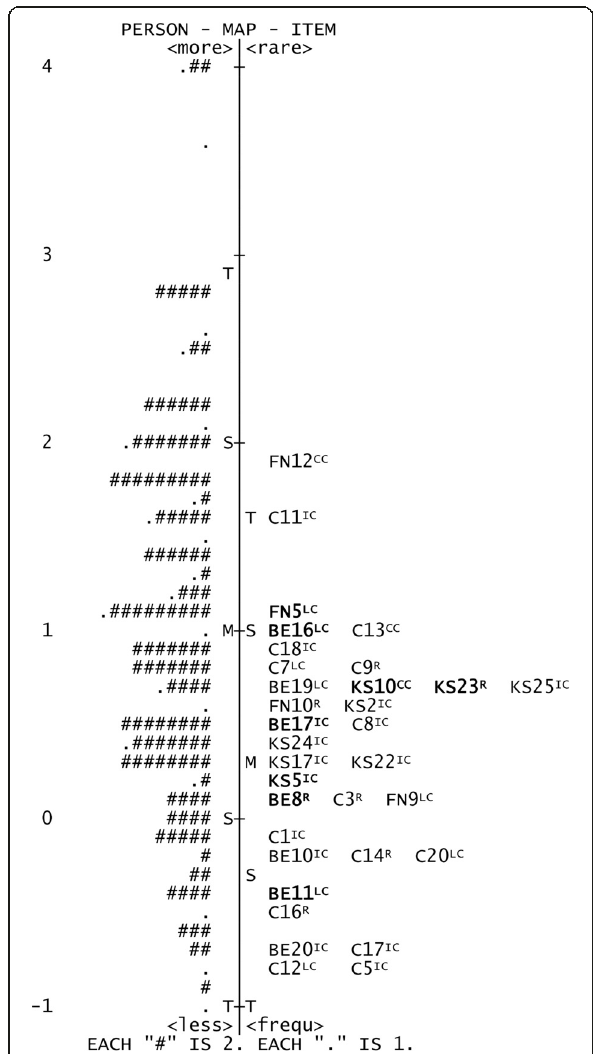
Fig. 7 Person-item variable map for